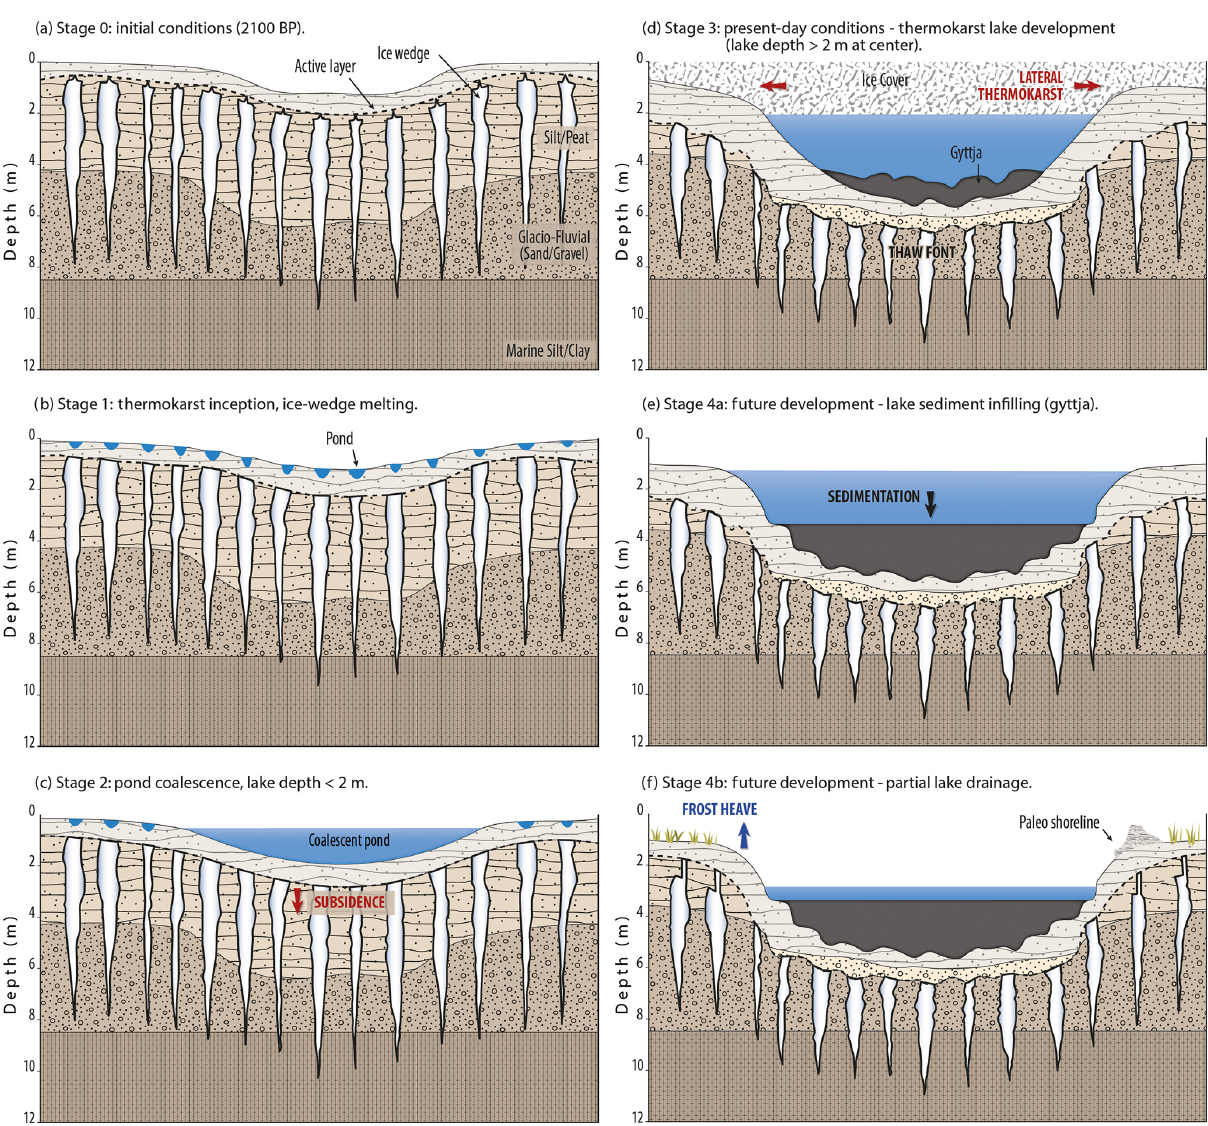
Figure 6. Four-stage conceptual model of thermokarst lake inception and evolution through the Holocene. (a) Stage 0: initial conditions with networks of ice wedges developed in frozen silt-peat and glacio-fluvial sand and gravel (and likely reaching underlying marine silts and clays). A pre-existing topographic depression of 1–2m was collecting drifting snow and meltwater. (b) Stage 1: thermokarst inception, i.e., deepening of the active layer, melting of the top of ice wedges (triggering ice wedge truncation) and development of a hummocky surface. (c) Stage 2: thermokarst pond coalescence and formation of a small lake with a maximum depth still above maximum ice cover thickness. (d) Stage 3: thermokarst lake mature development by lateral expansion (thermal and mechanical erosion) and bottom deepening (subsidence). Lake maximum depth is now below maximum ice cover thickness, triggering the formation of a talik. (e) Stage 4a: possible future evolution by lake infilling (gyttja accumulation). (f) Stage 4b: possible future evolution by lake drainage (partial or complete) and reactivation of ice-wedge cracking and growth (i.e., no more